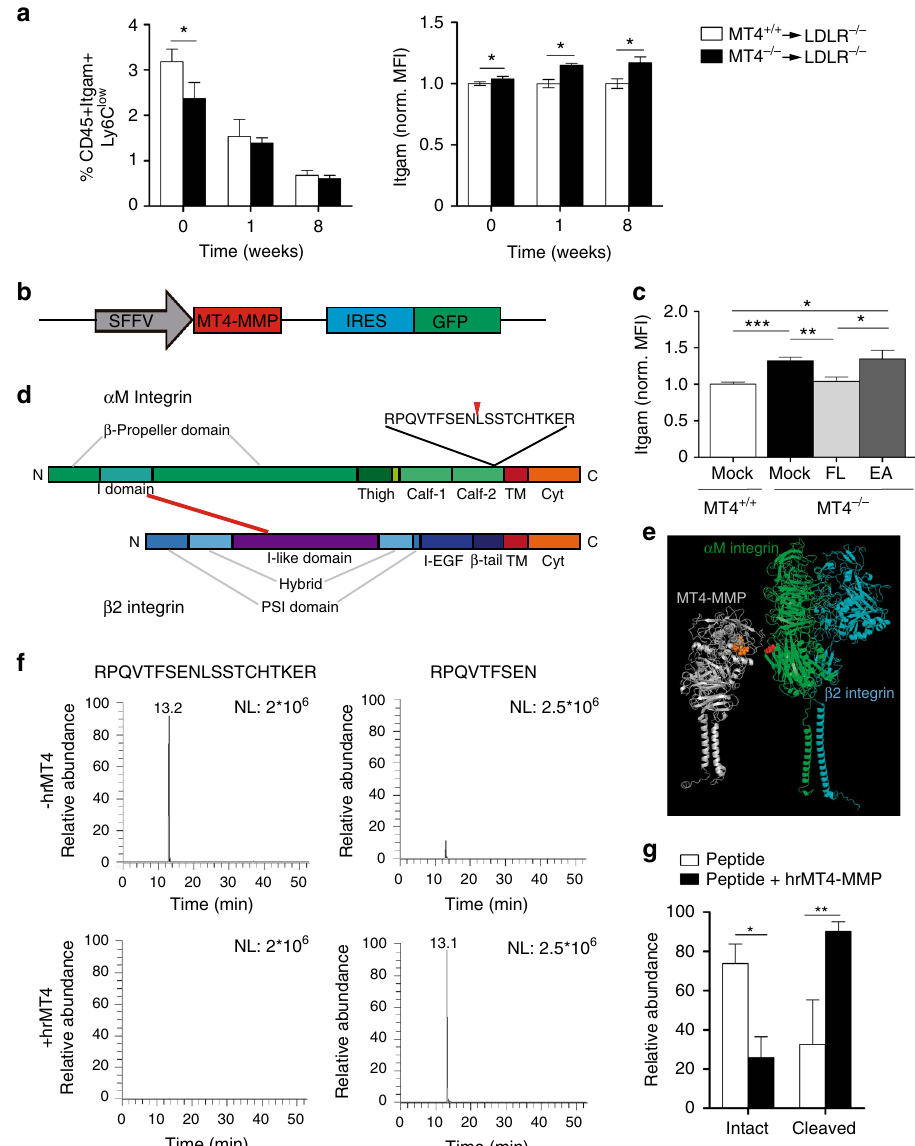
Fig. 3 The protease MT4-MMP can cleave the α M integrin chain (Itgam). a Percentage of circulating patrolling monocytes (CD45 + Itgam + Ly6Clow, excluding granulocytes) and the normalized mean fl uorescence intensity (MFI) of Itgam cell-surface levels in patrolling monocytes from Ldlr – / – mice transplanted with MT4-MMP + / + or MT4-MMP – / – BM cells and fed a HFD for 0, 1, or 8 weeks; n = 12, n = 6, and n = 6 mice in basal, 1 week and 8 weeks per genotype; four independent experiments in basal and two independent experiments at 1 and 8 weeks. b Design of lentiviral (LV) vector with SFFV- driven Mmp17 (MT4-MMP) expression and IRES-driven expression of green fl uorescent protein (GFP). c LV encoding full-length mouse MT4-MMP (FL), the catalytic inactive mutant (E248A, EA), or GFP only (mock) were i.p. injected into MT4-MMP-null mice. Itgam cell surface levels were assessed by fl ow cytometry in the infected peritoneal macrophages (GFP + Itgam + F4/80 + ) 5 days after infection; n = 6 mice per condition in two independent experiments. d Depiction of human α M β 2 integrin domains, indicating the predicted cleavage site at position 977 in the Calf-2 domain of human α M integrin. e In silico model of human MT4-MMP dimer (gray) and α M β 2 integrin ( α M chain, green; β 2 chain, blue) showing the putative cleavage site between N977 and L978 (red) in the α M chain, and the catalytic active center in the MT4-MMP dimer (orange). f Representative extracted ion chromatogram of peptides obtained after incubation of the synthetic human α M integrin peptide RPQVTFSENLSSTCHTKER in the presence or absence of human recombinant MT4-MMP catalytic domain (hrMT4). g Quanti fi cation of the relative abundance of the intact RPQVTFSENLSSTCHTKER and N-terminal peptide fragments in each condition; n = 4 independent experiments. Data were tested by two-way ANOVA followed by Bonferroni ’ s post test in a , by one-way ANOVA followed by Bonferroni ’ s post test in c , and by two-tailed Student ’ s t -test in g . IRES, internal ribosome entry site; SFFV, spleen focus-forming virus. Results are expressed as mean ± SEM. * p < 0.05, ** p < 0.01, and *** p <